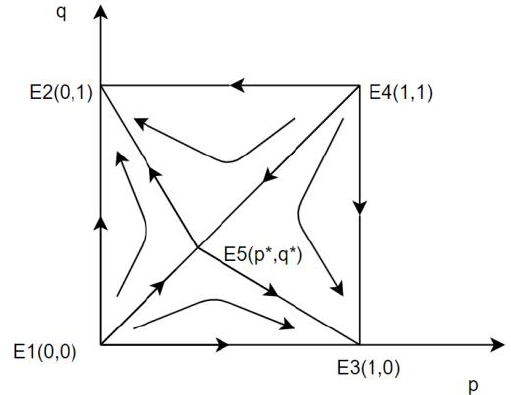
Figure 1. System dynamic evolution diagram.